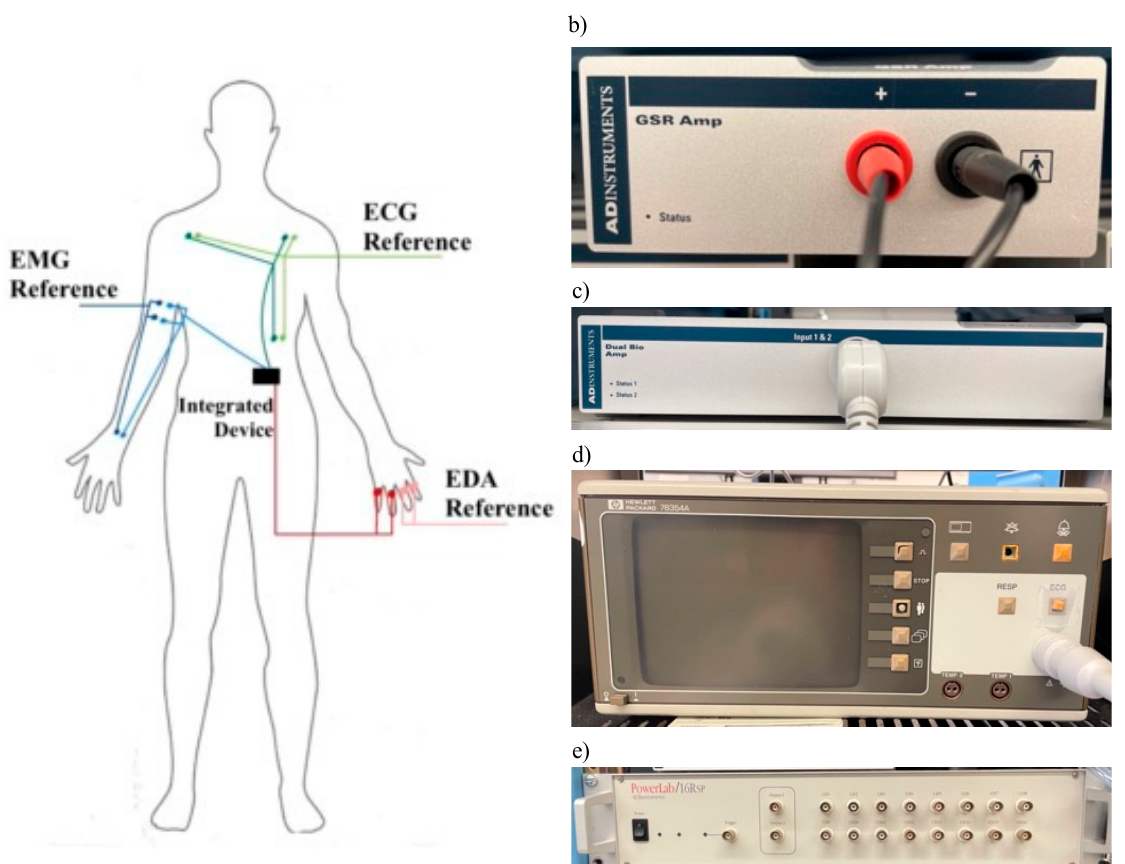
Figure 2. ( a ) Placement of electrodes from prototype and reference devices on subject; ( b ) ADI GSR Amp ( c ) ADI Dual Bio Amp ( d ) HP ECG Module; ( e ) PowerLab system used to acquire signals from separate modules and prototype outputs.